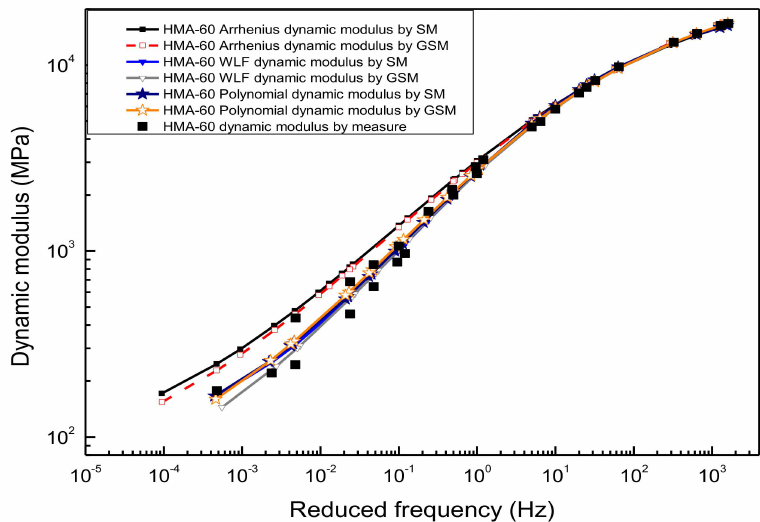
Figure 10. Compared the dynamic modulus master curve obtained by di ff erent